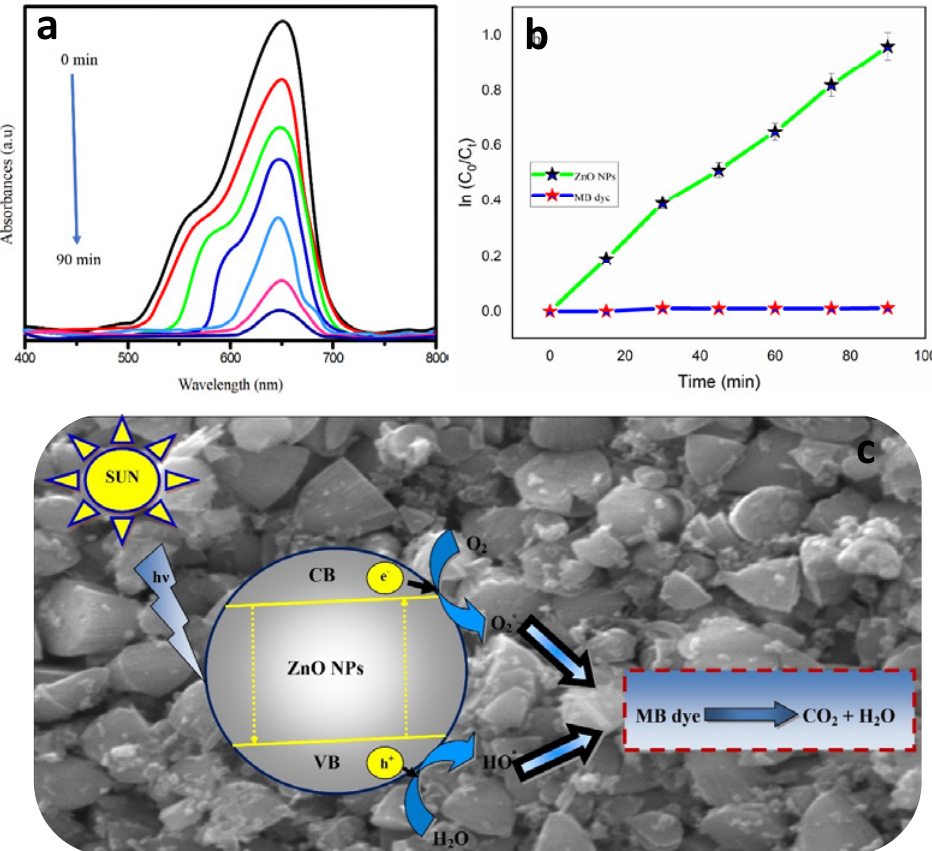
Fig. 8. (a) UV-vis absorption spectra of MB dye with respect to irradiation time versus; (b) rate constant (K) and regression (R2) and (c) Mechanism for photodegradation of MB dye of biosynthesized ZnO